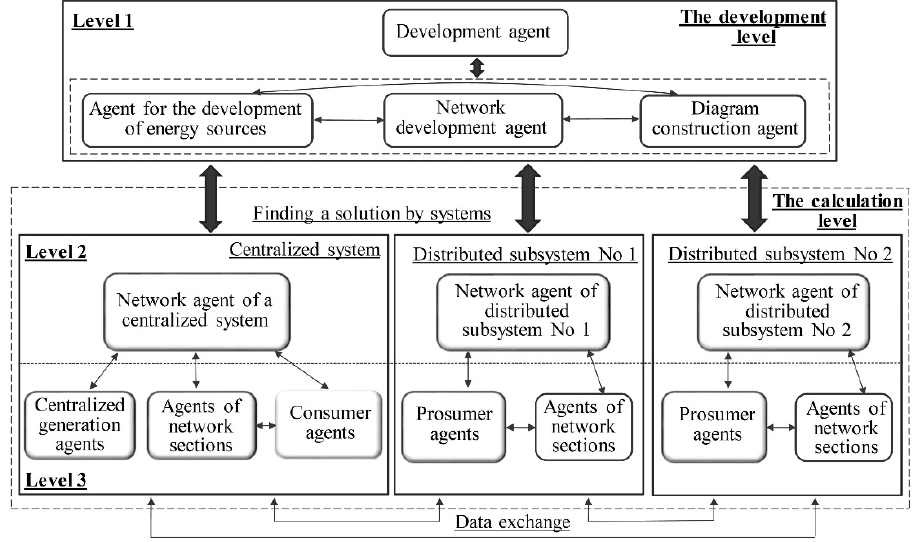
Figure 4. The structure of a multi-agent system for solving the development problem.